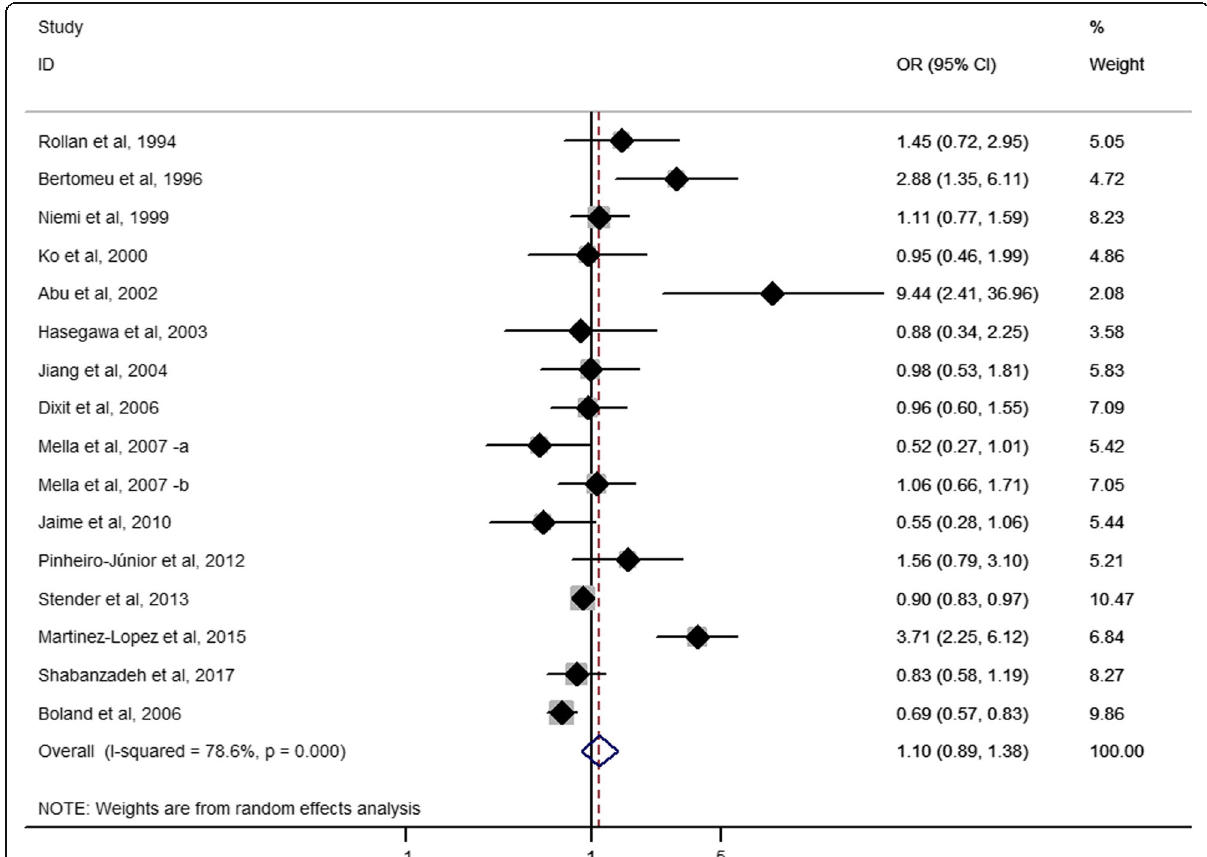
Fig. 4 Forest plot for meta-analysis of the association of APOE E4 with GSD risk after including the study by Boland et al. Each study is represented by a square whose area is proportional to the weight of the study. The overall effect from meta-analysis is represented by a diamond whose width represents the 95% CI for the estimated odds ratio (OR). GSD, gallstone disease; OR, odds ratio; CI, confidence